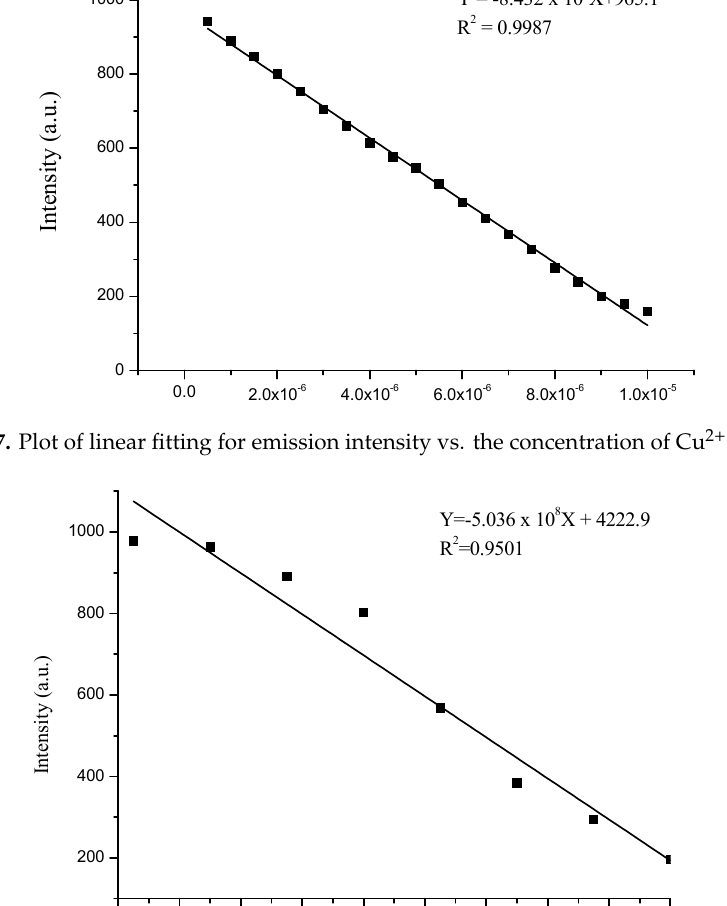
Figure 8. Plot of linear fitting for emission intensity vs. the concentration of Fe 3+ (mol/L).